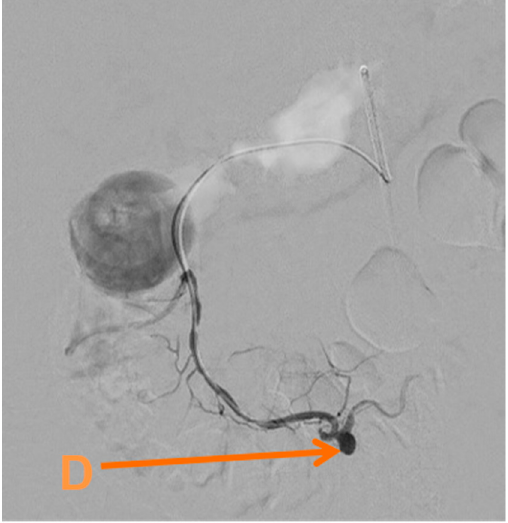
Figure 3. Selective angiogram showing ( D ) a pseudoaneurysm of the inferior pancreaticoduodenal